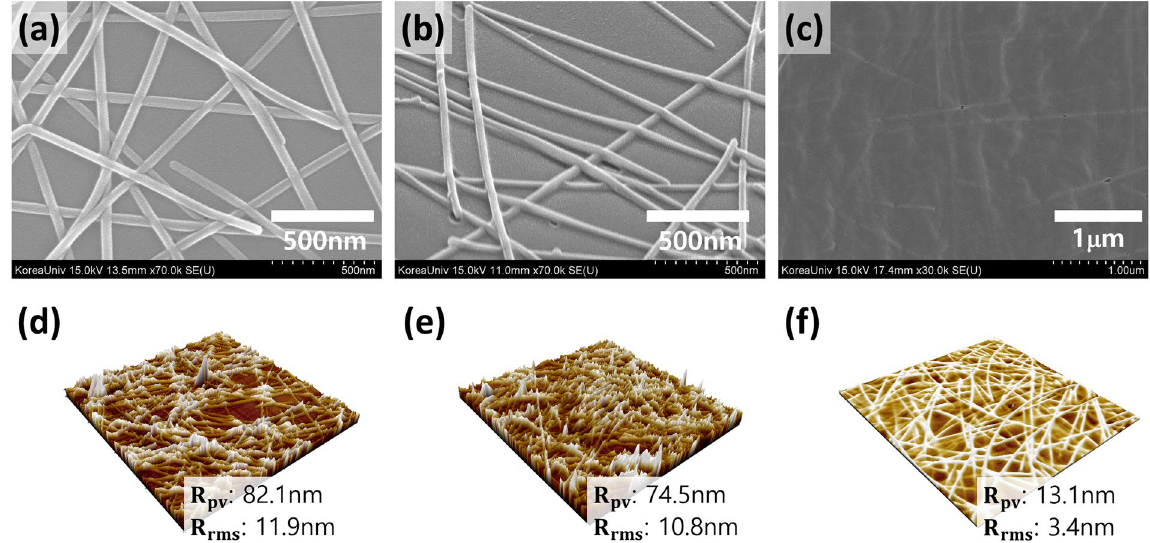
Figure 2. SEM images of ( a ) Glass/AgNWs, ( b ) Glass/AgNWs with IPL, and ( c ) PVB/AgNWs. AFM topography images of ( d ) Glass/AgNWs, ( e ) Glass/AgNWs with IPL, and ( f )